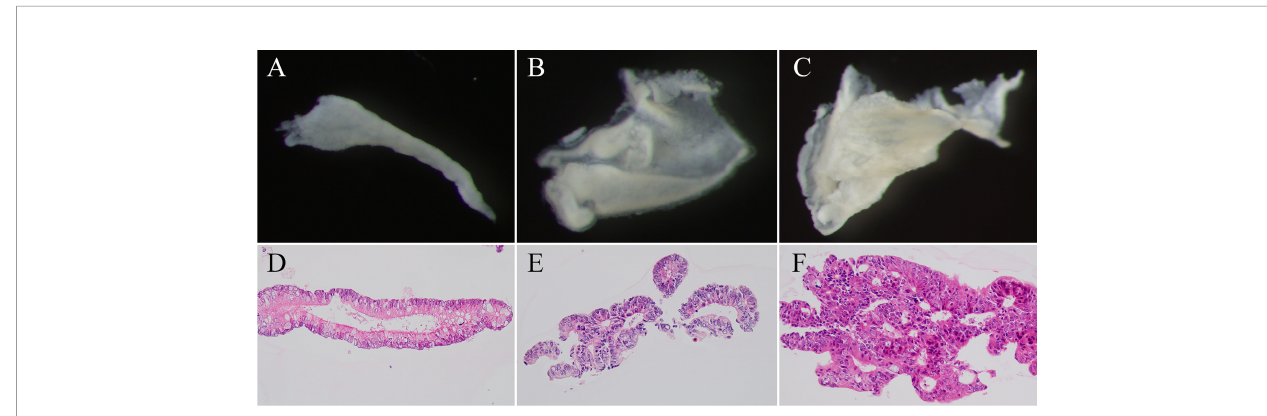
FIGURE 1 | Representative image of isolated crypts. (A – C) Isolated glands under a dissecting microscope. (D – F) Hematoxylin – eosin staining of isolated crypts. Isolated crypts of low grade tubular adenoma (A, D) , intramucosal cancer (B, E) , and invasive cancer (C, F) .